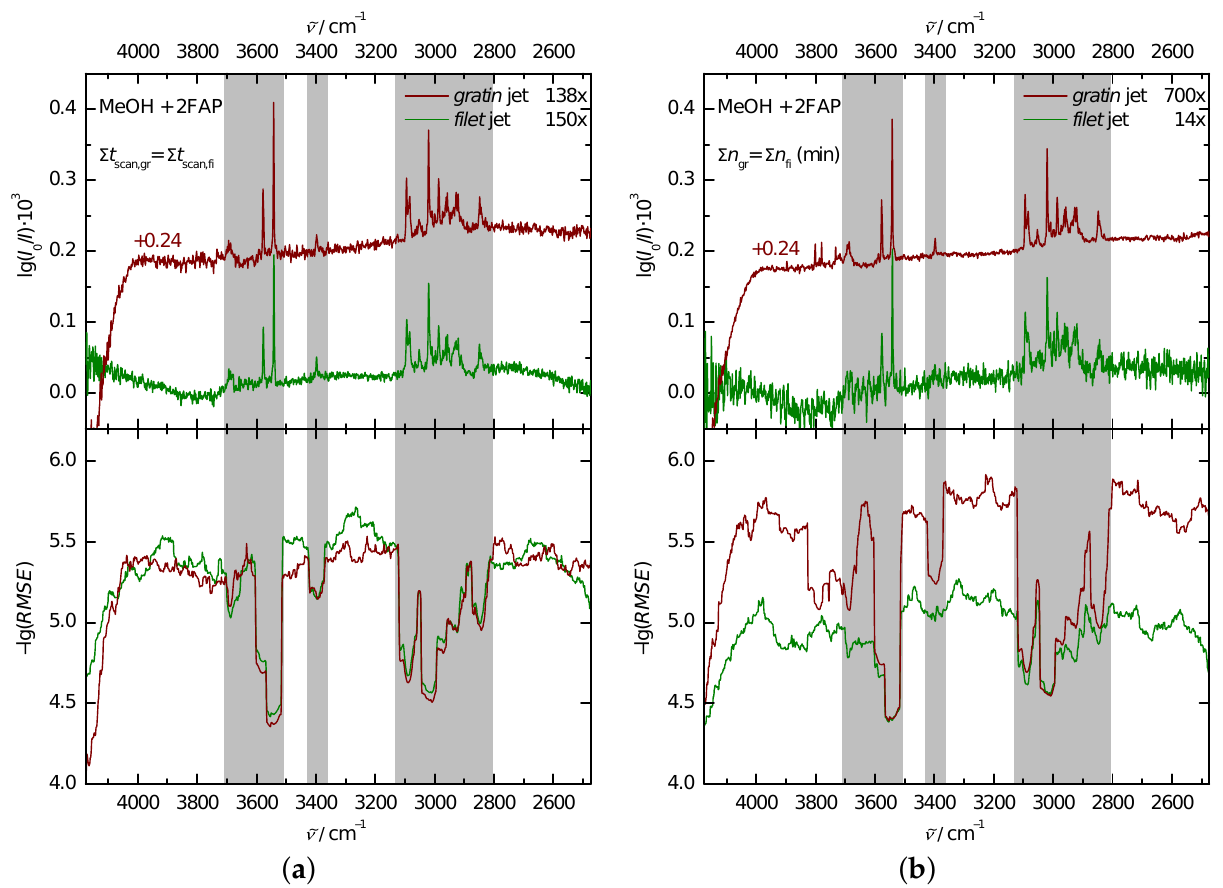
Figure 10. Upper panel, ( a ): comparison of spectra of MeOH+2FAP in He with the same total scan time Σ t scan (138 pulses at the gratin (gr, red, displaced by + 0.24 along the ordinate), 150 pulses at the filet (fi, green) jet). Upper panel, ( b ): as ( a ), but for the same substance consumption Σ n at filet and gratin jet. As a point of reference, the lowest possible consumption at the gratin jet (1 filling of the reservoir) was chosen. Lower panels: negative decadic logarithm of the root-mean-square error ( − lg( RMSE )) of the noise level in a 50 cm − 1 moving window with respect to a quadratic fit of the baseline. The spectral regions occupied by absorption bands of the sample mixture, which cannot be used for the analysis of the noise level, are shaded in